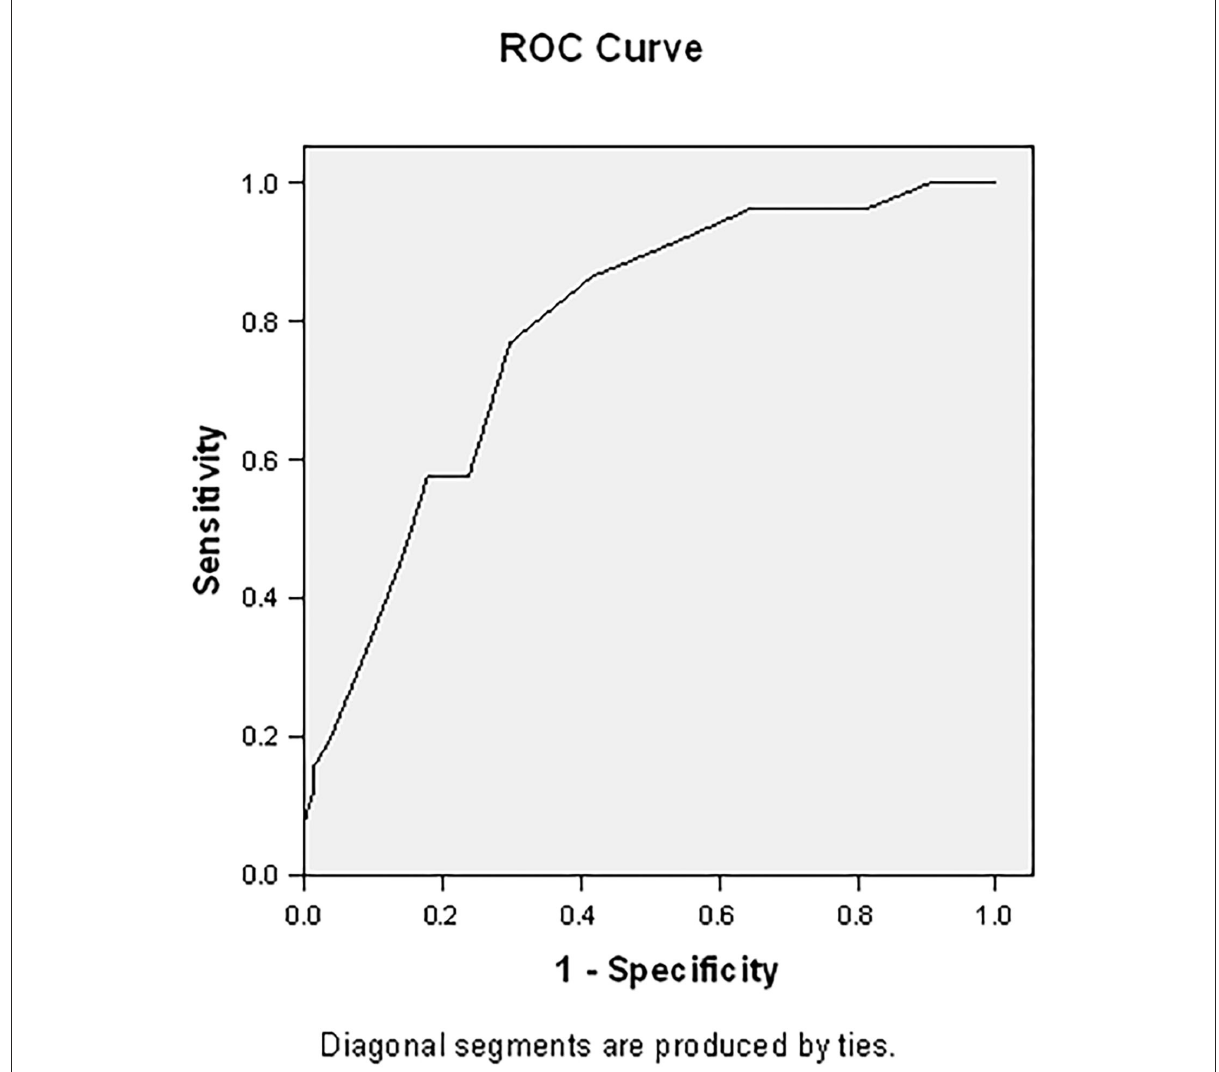
FIGURE2 Area under the curve for responder score. The responder score has an area under the curve of 0.786 (95% CI 0.709–0.863, p <